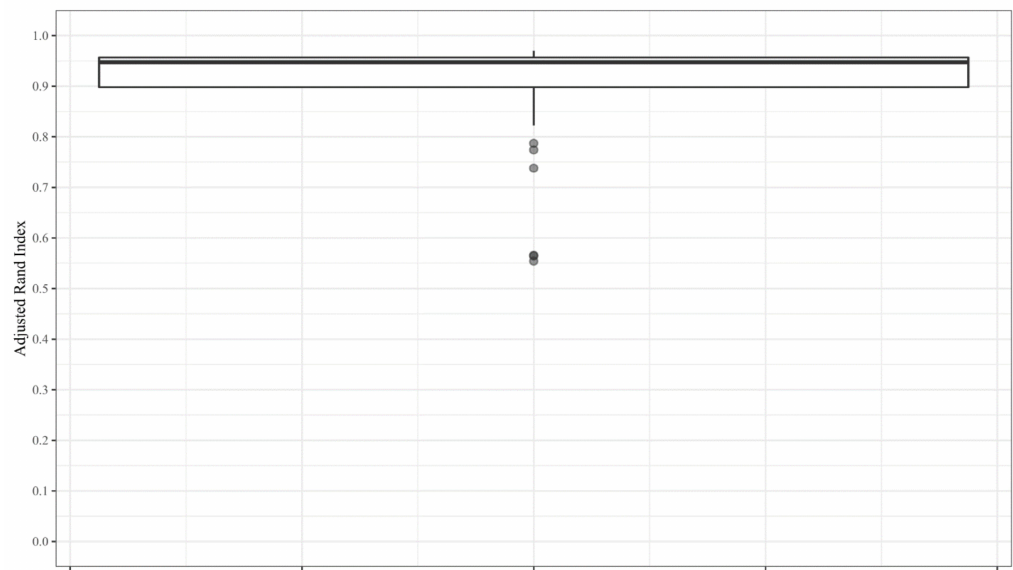
Figure A1. Boxplot of 50 values of the adjusted rand index obtained by comparing the similarity of the clustering of truncated samples with the final k-means partitioning into seven